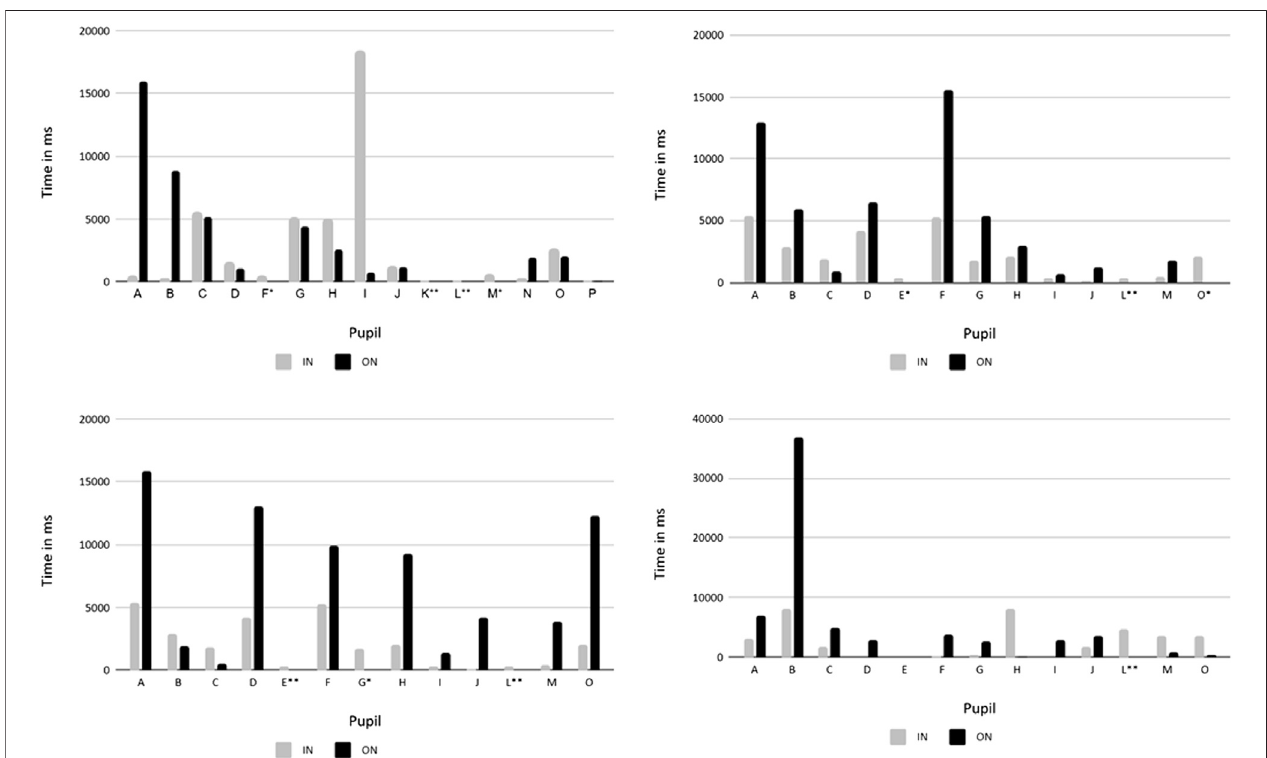
FIGURE 5 | Dwell times for individual pupils in IN and ON condition T1 (from left to right — T1_1, T1_2, T1_3, T1_4). Two stars — pupil invisible in ON condition; one star — pupil poorly or rarely visible or almost invisible in ON